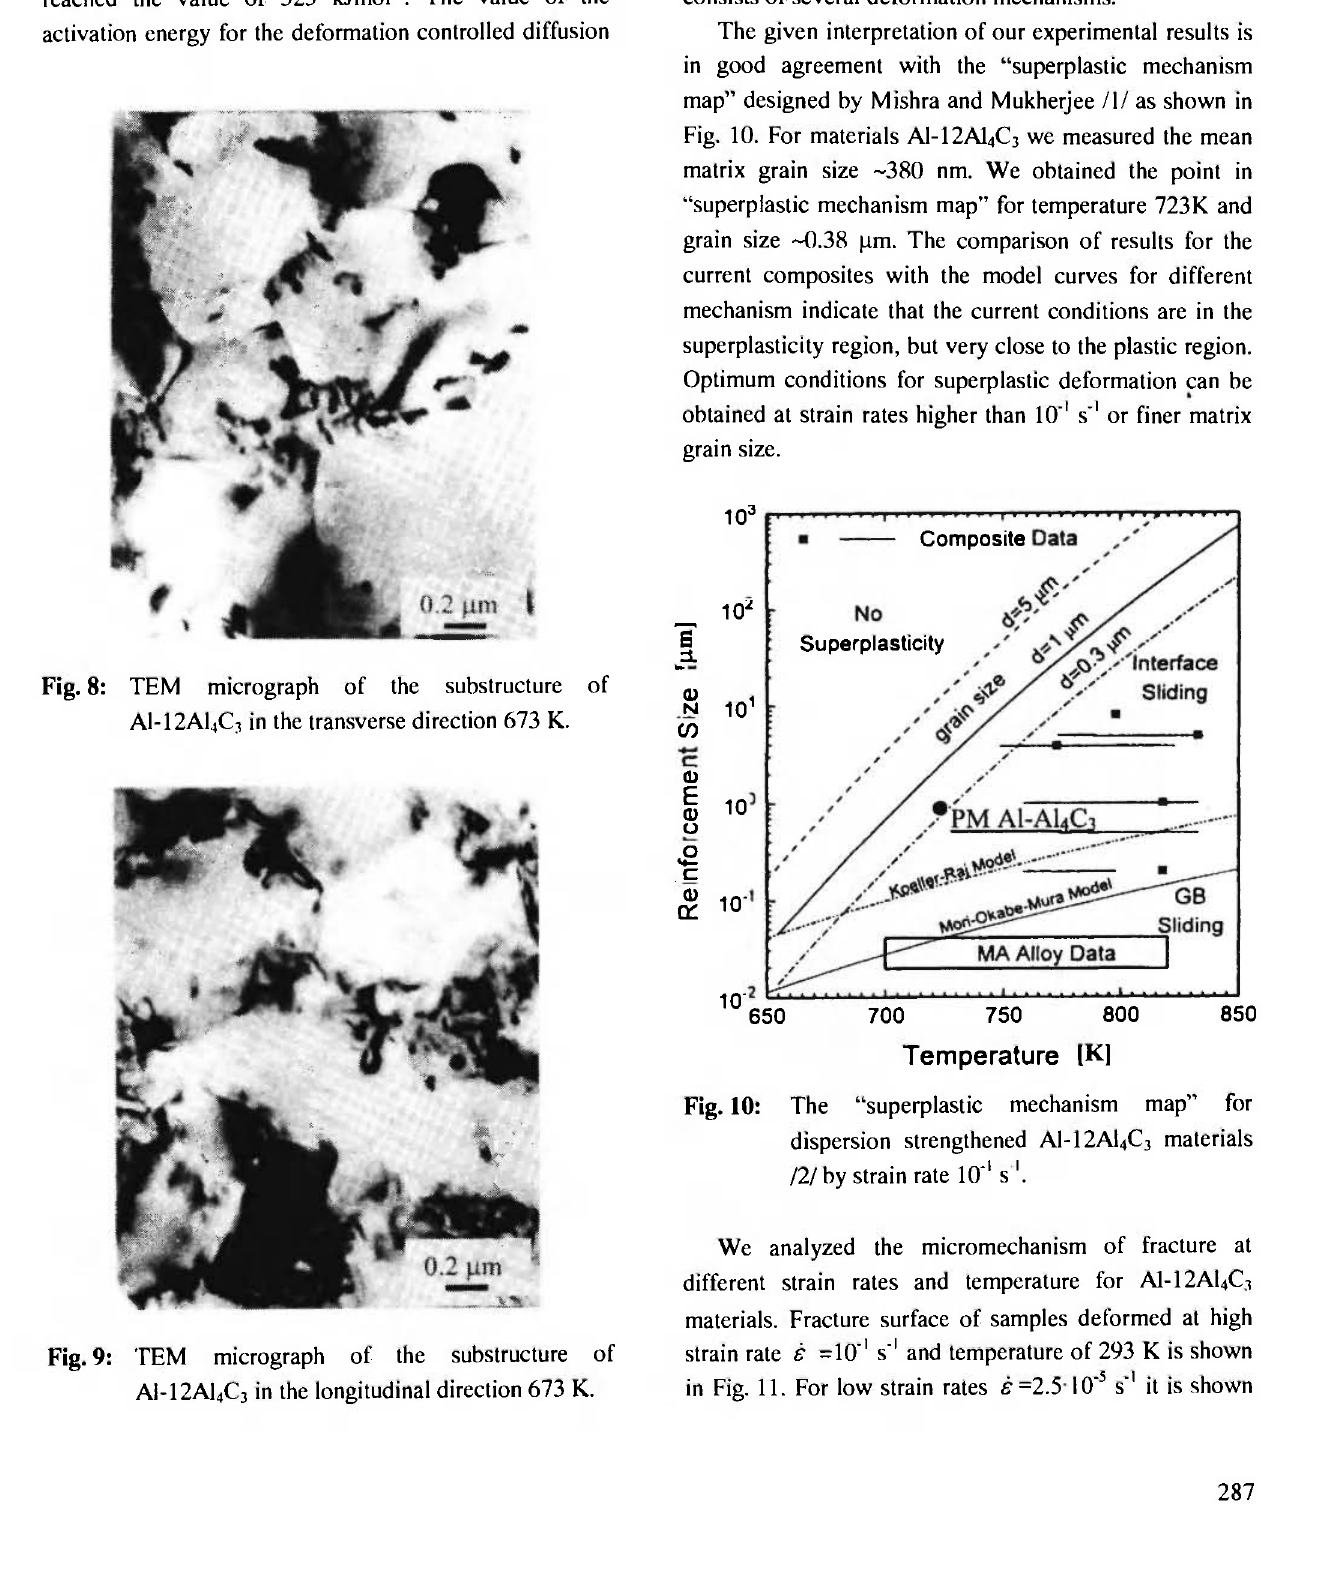
The "superplastic mechanism map" for dispersion strengthened A1-12A1 4 C 3 materials 121 by strain rate 10"'